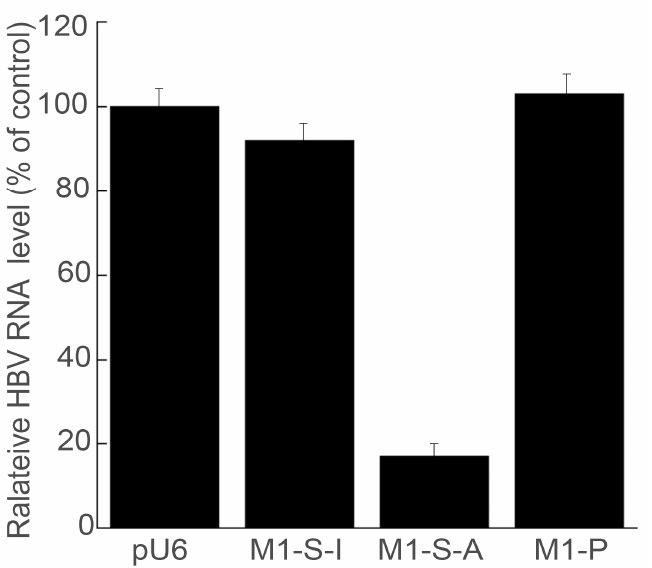
Figure 3. Inhibition of HBV RNA expression in HepG2.2.15 cells expressing RNase P ribozyme. RNA samples were isolated from cells and assayed for HBV RNA expression using Northern blot analysis with actin mRNA as the loading control. Experimental details are described in Materials and Methods. The values, which are the average of triplicate experiments, represent the relative percentage of the levels of HBV RNAs in cells with different ribozymes, as compared to those in cells with empty vector pU6. The error bars show the standard deviation.